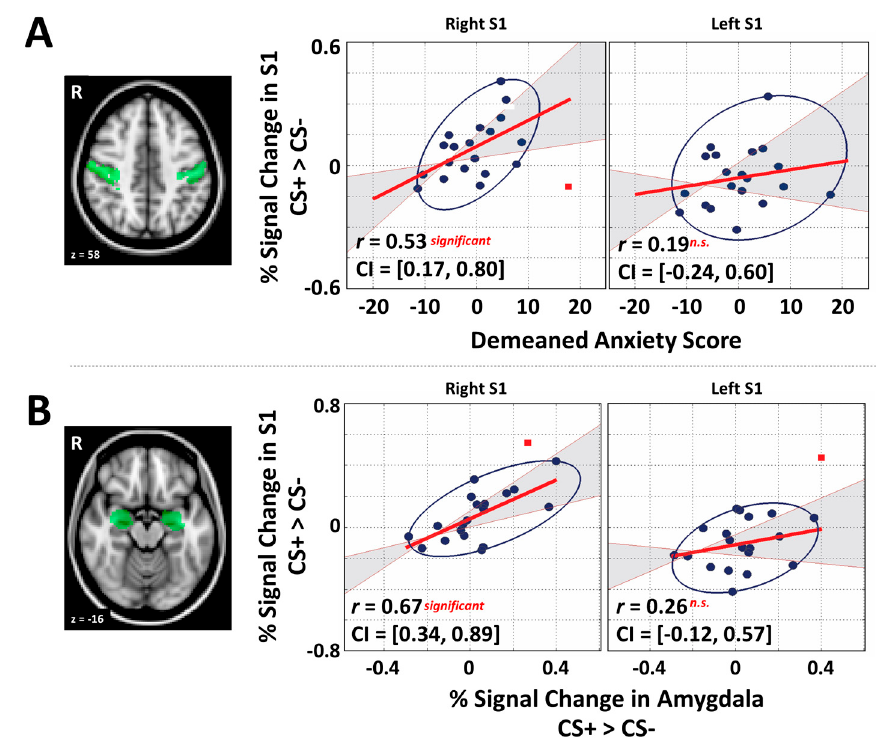
Figure 2. ( A ) The anatomical structural masks of S1 used in this study and scatter plots illustrating the correlation between individual trait anxiety level and evoked signal in the S1 ROI of the right and left hemispheres, respectively; ( B ) the anatomical structural masks of amygdala (bilateral) and scatter plots illustrating the correlation between evoked signal in the amygdala and the S1 region. Gray-shaded area indicates 95% bootstrapped CIs. Red square data points indicate bivariate outliers that were identified by the robust method [44].